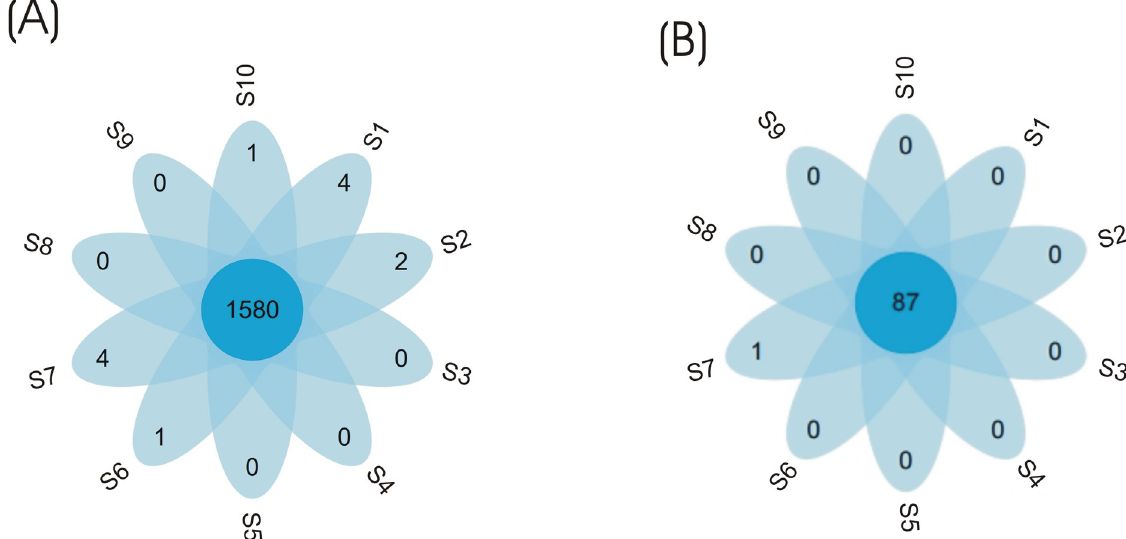
Fig 4. Petal flower map-based operation taxonomic units for eubacterial and archaeal communities. Each petal in the petal map represents one sample. The middle core number represents the common OTUs of all samples and the number on the petals represents the unique OUT number of each